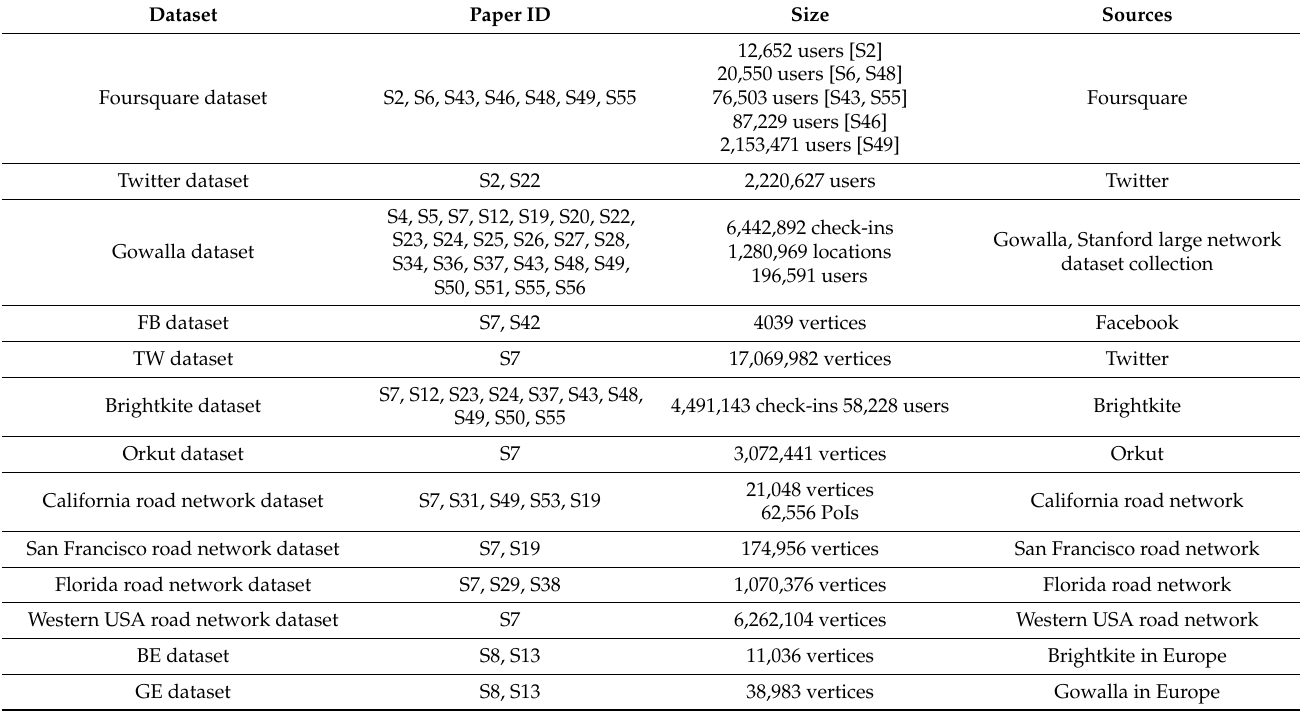
Table 19. Real-world datasets used by the selected